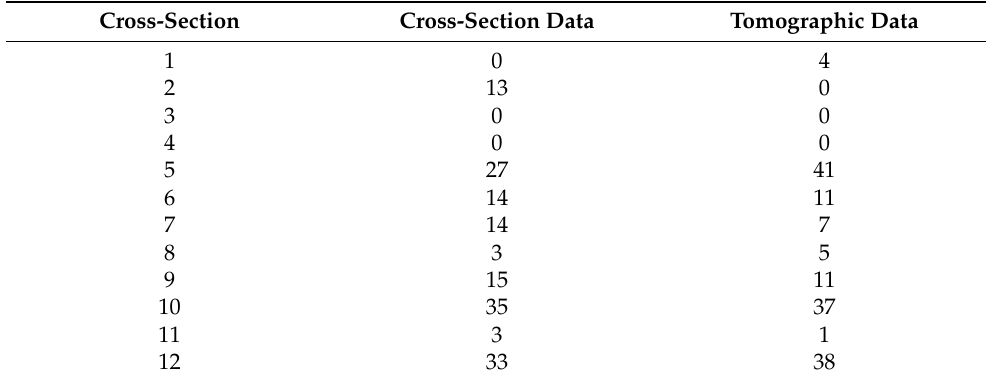
Table 5. Strength loss percentage values using Equation (9) with data from actual cross-sections and tomographic